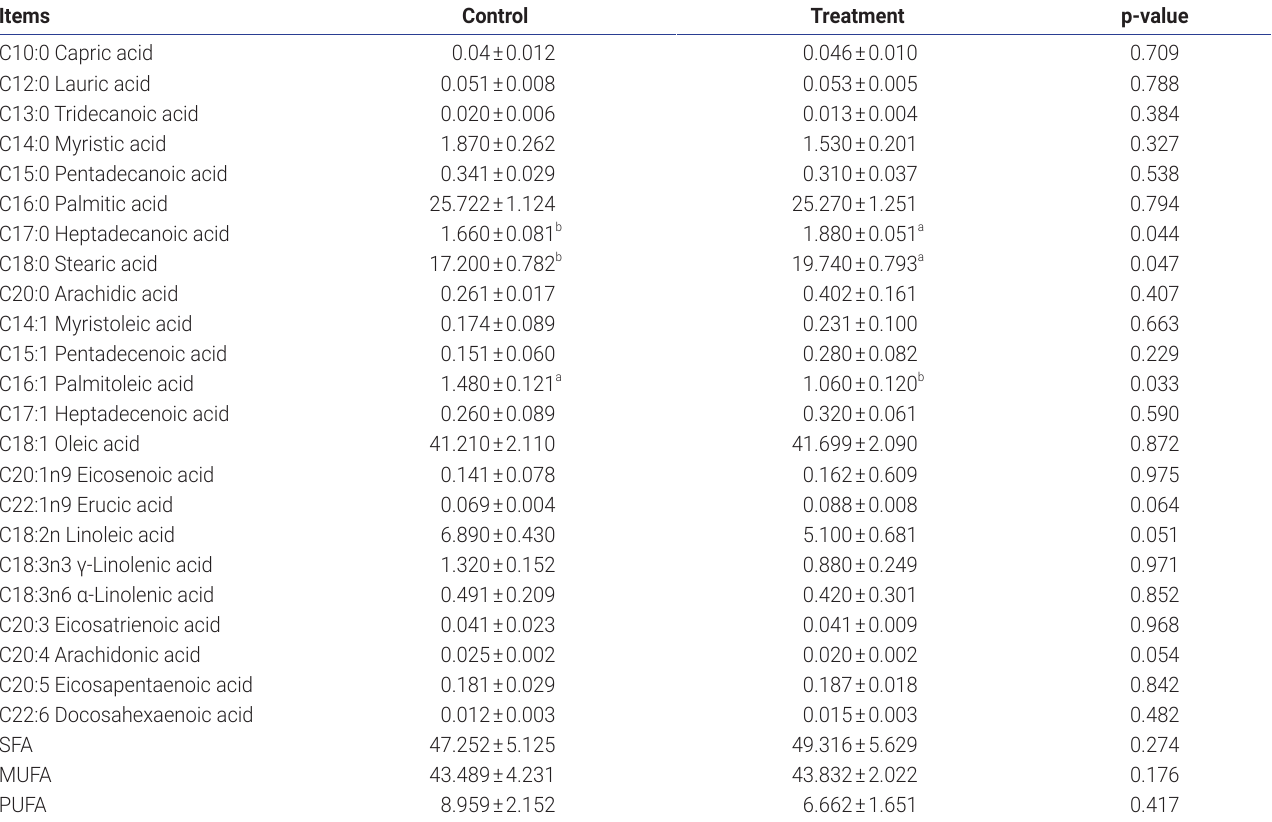
Table 8. Fatty acid composition (% of total fatty acids) in intramuscular fat of Jinjiang cattle Items Control Treatment p-value